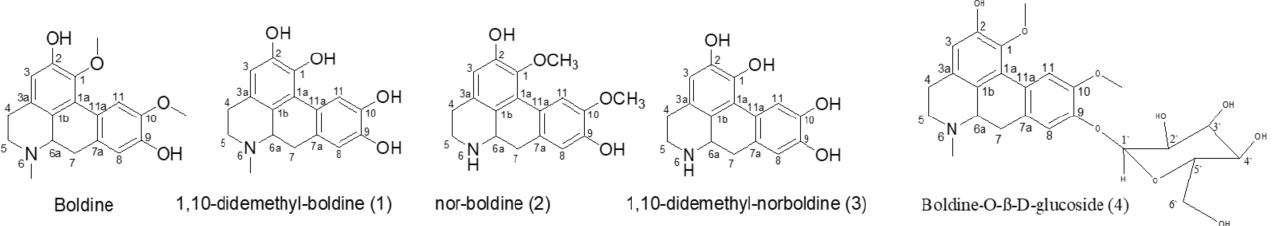
which is 14 Da less than that of boldine. Based on boldine metabolite- 2 spectral data, it